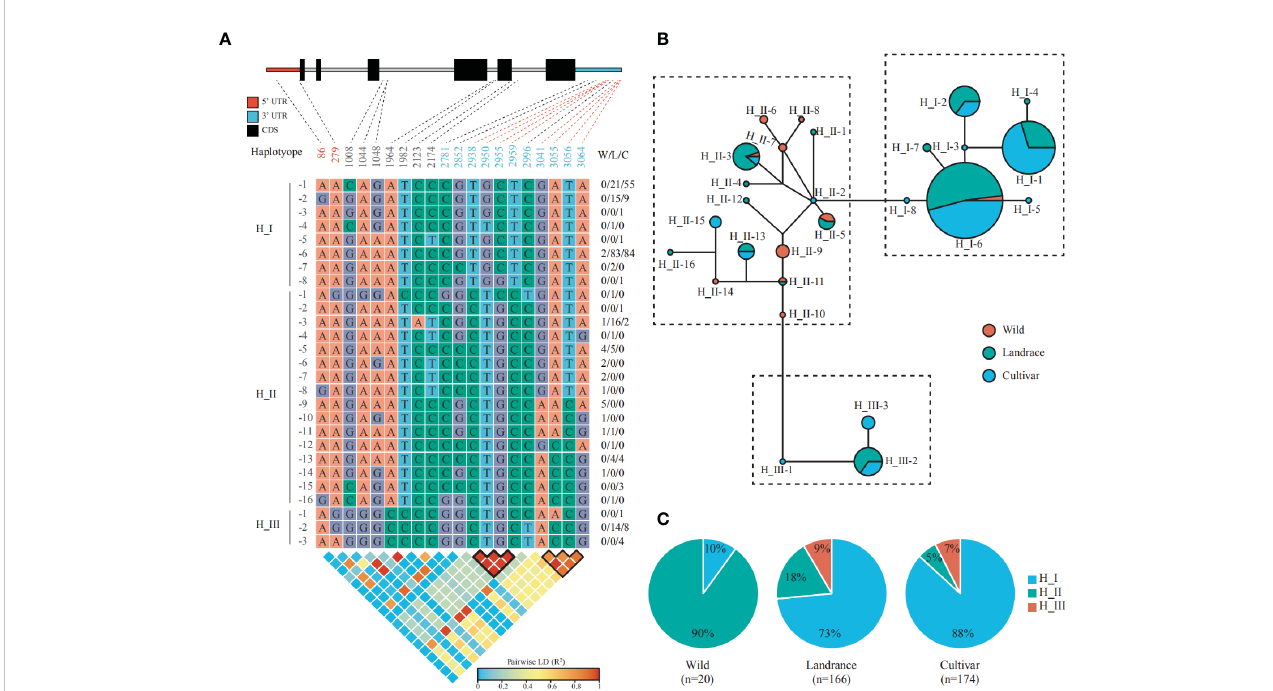
FIGURE 5 Arti fi cial selection of HvSWEET1a gene during barley domestication and improvement. (A) Genetic variations detected in the genomic region of HvSWEET1a in the published exome re-sequencing data of 360 accessions (Bustos-Korts et al., 2019). The SNP positions are indicated relative to the gene start site of HvSWEET1a , 634,920,942 on chromosome 3, and displayed below gene structure, linked with dashed lines. The red dashed lines and black outlines denote the SNPs in strong LD regions in top and bottom panel, respectively. The W/L/C indicates the number of wild accessions, landraces and cultivars, respectively. The pairwise linkage disequilibria (LD) between SNPs are measured using R 2 . (B) Median-joining network representing the relatedness of 27 HvSWEET1a haplotypes, each represented by a circle with size proportional to the corresponding haplotype population size. Wild accessions, landraces and cultivars are indicated by red, green and blue colors, respectively. (C) Allele frequency distribution of three main haplotypes. H_I, blue; H_II, green; H_III, red. The accession number (n) is shown below the corresponding